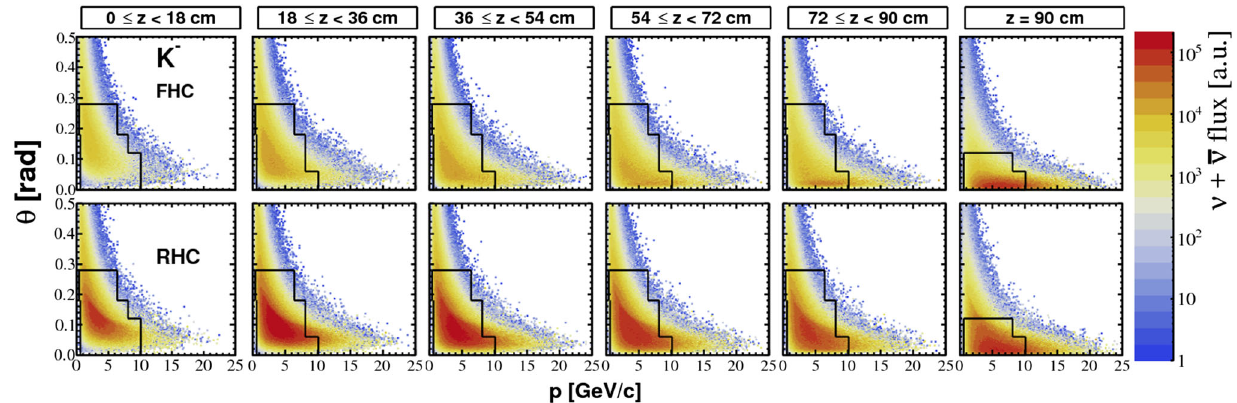
Fig. 9 The p − θ distribution of positively charged kaons emitted from the surface of the T2K target which contribute to the (anti)neutrino flux in Super-Kamiokande . The top row shows the phase space plots in the forward horn current configuration, while bottom plots show the phase